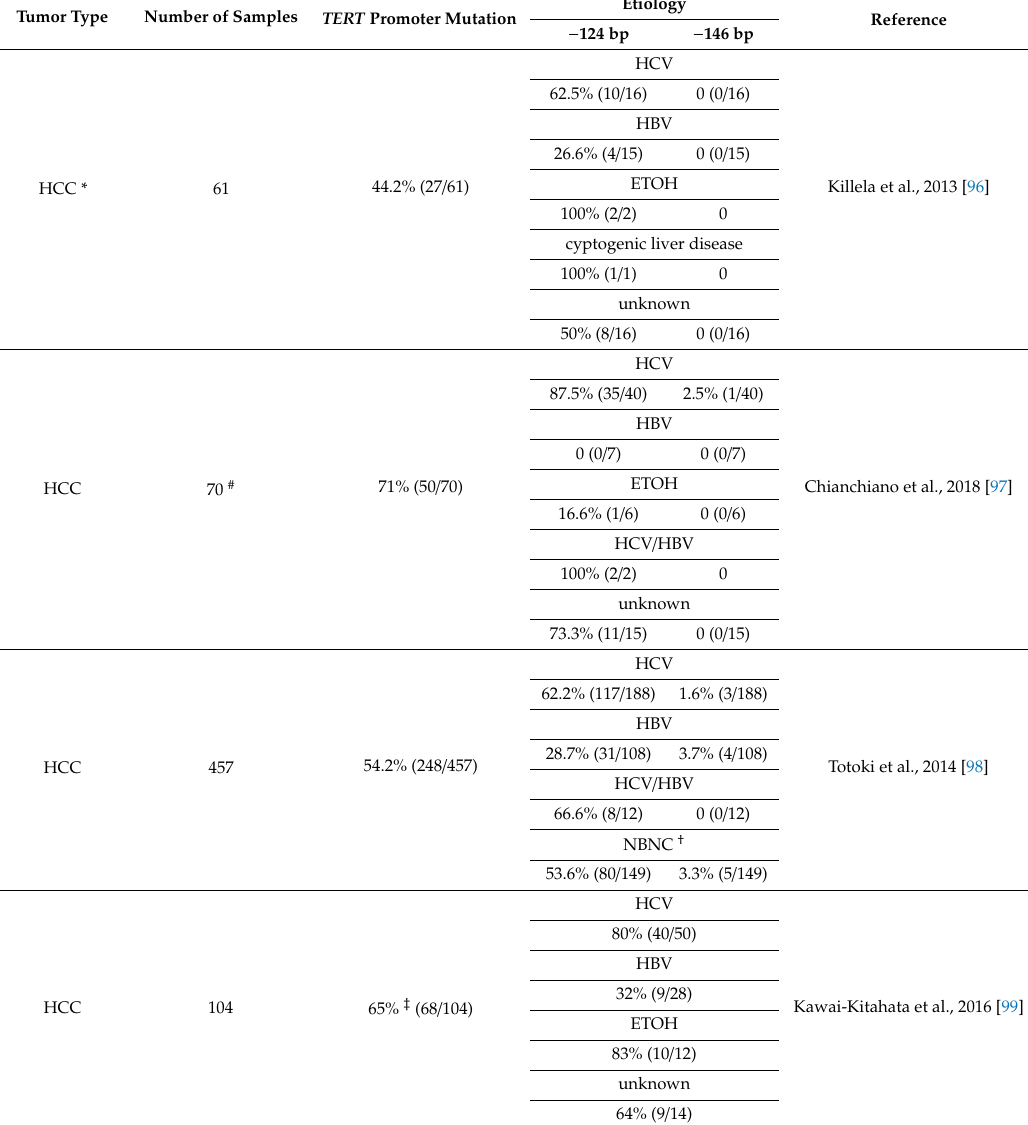
Table 1. TERT promoter mutations in hepatocellular